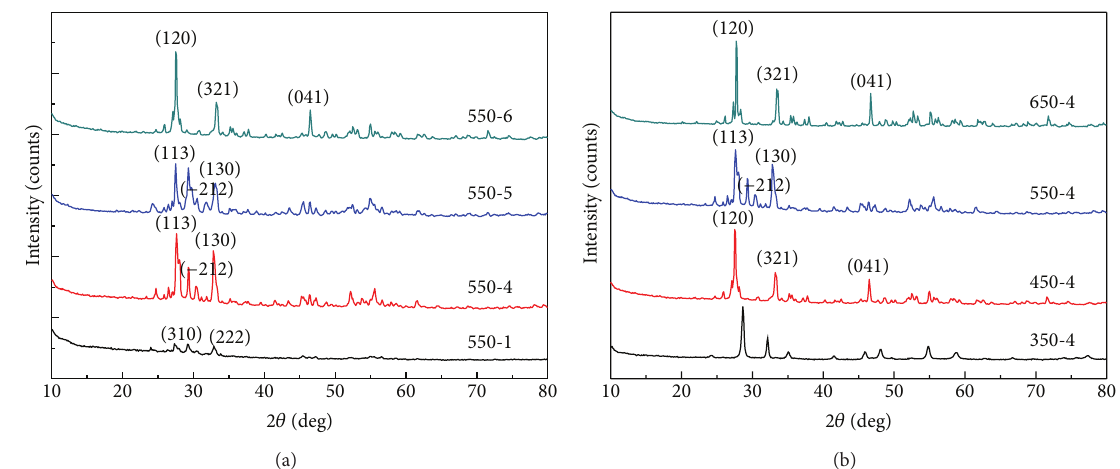
Figure 4: XRD patterns of samples: (a) samples with different calcination time at 550 ∘ C; (b) samples with different calcination temperature for